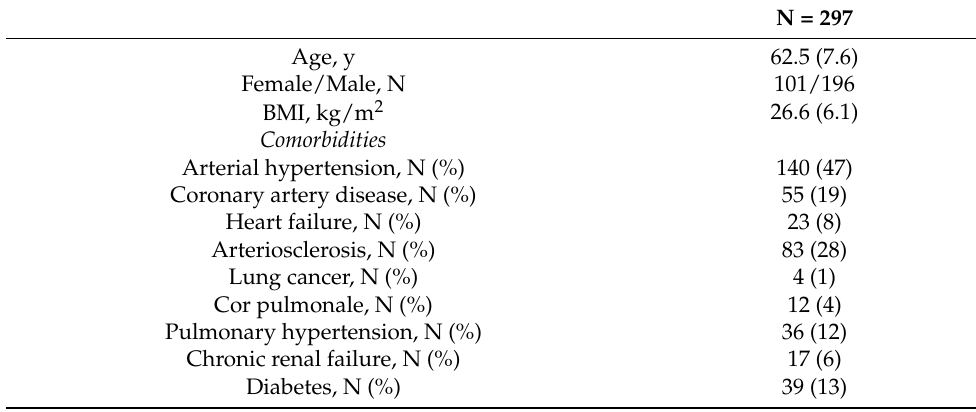
Table 1. Subject